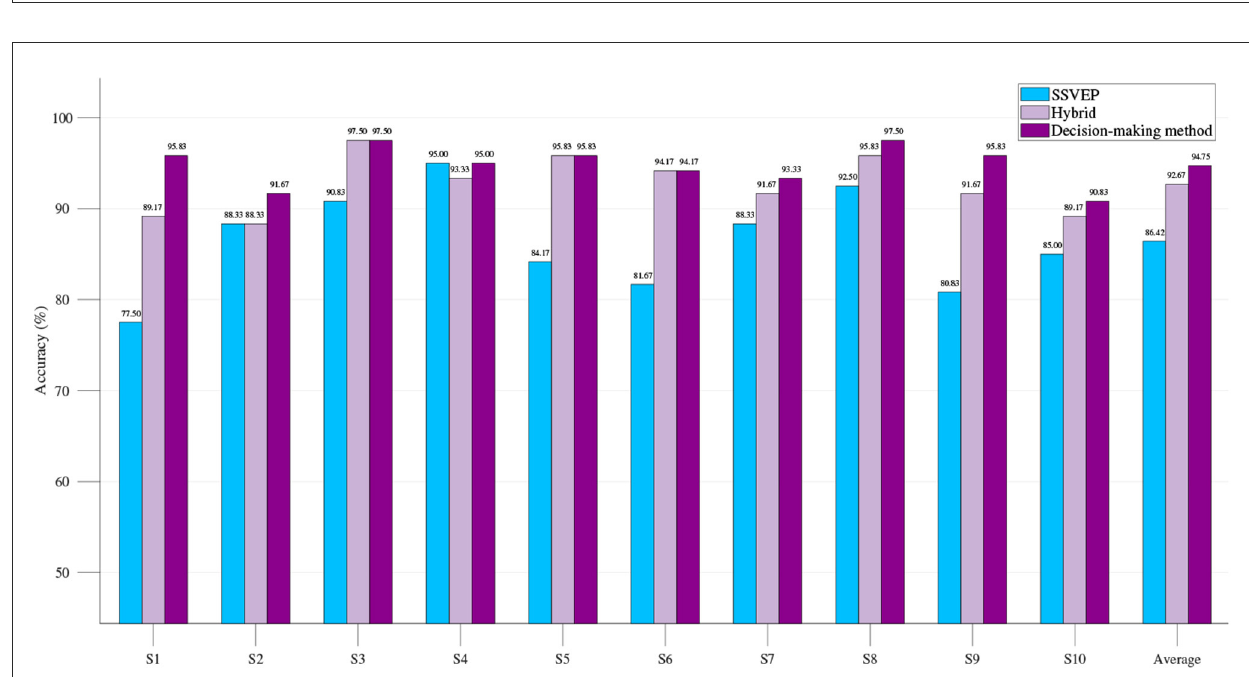
FIGURE11 Classification accuracy of single-modality SSVEP BCI system, hybrid BCI system, and hybrid BCI system using decision-making method based on SSVEP and EOG.